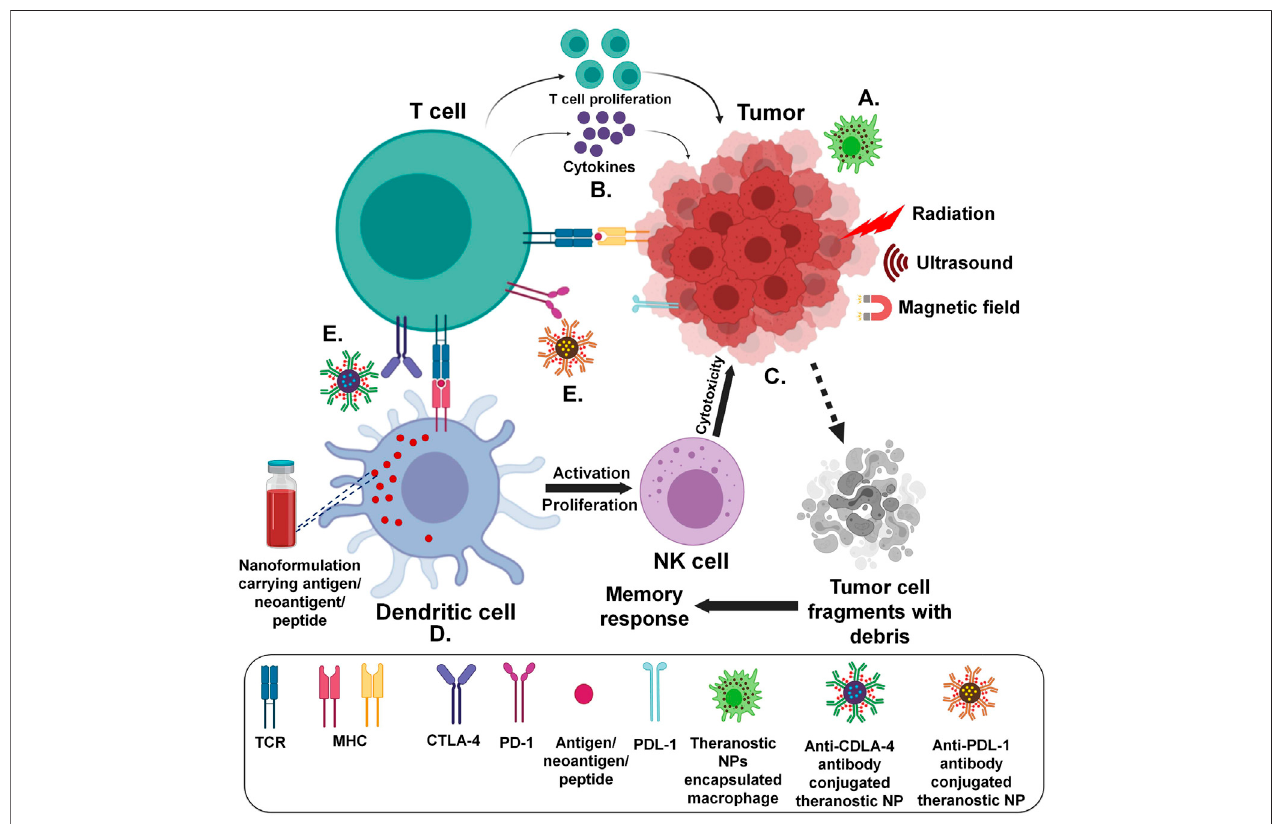
FIGURE2| Strategiesforantitumor immunesystemtargeted deliveryoftheranosticNPs(CreatedwithBioRender.com) (A) Immunecell/membrane entrapped (B) Direct/indirect cytokine release assisted (C) Tumor microenvironment and components targeted (D) Utilizing antigen presenting cells (E) Antibody mediated.